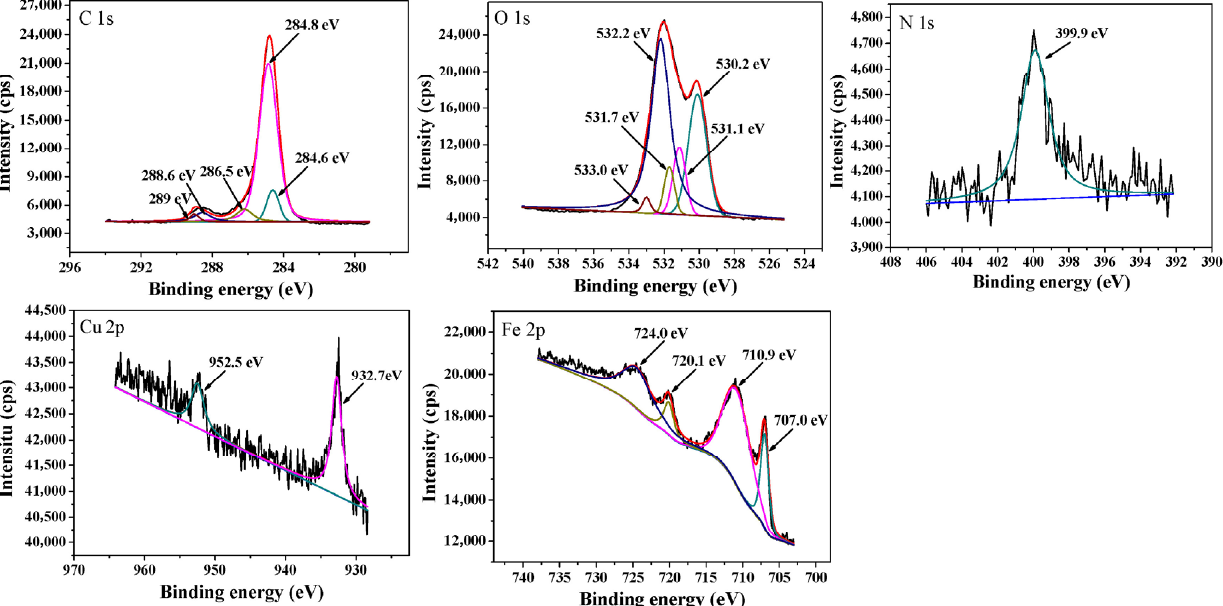
Fig. 12 XPS spectra of wear track on 304 stainless steel plate lubricated by aqueous solution of 0.8 wt% CuO nanorods (speed: 0.02 m/s, load: 2.0 N, time: 30